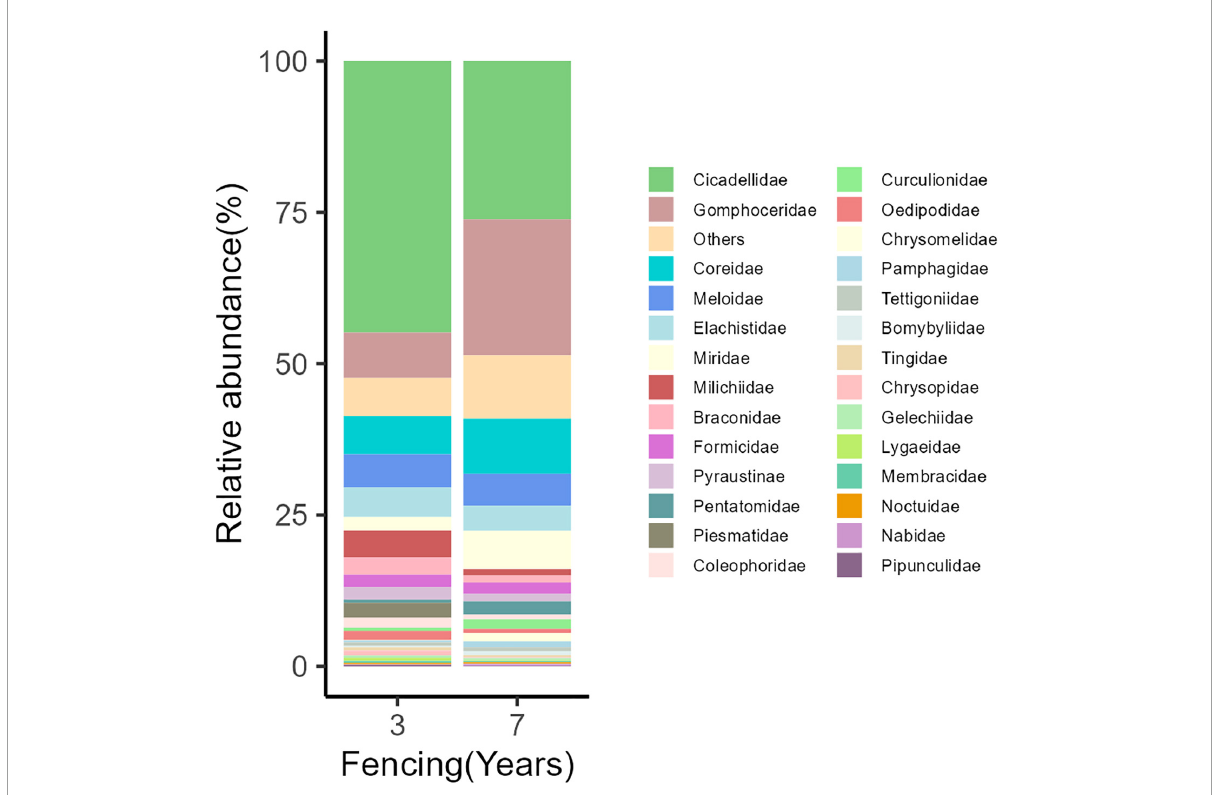
FIGURE1 Proportional abundance of insect species collected from two fencing periods in a desert steppe.